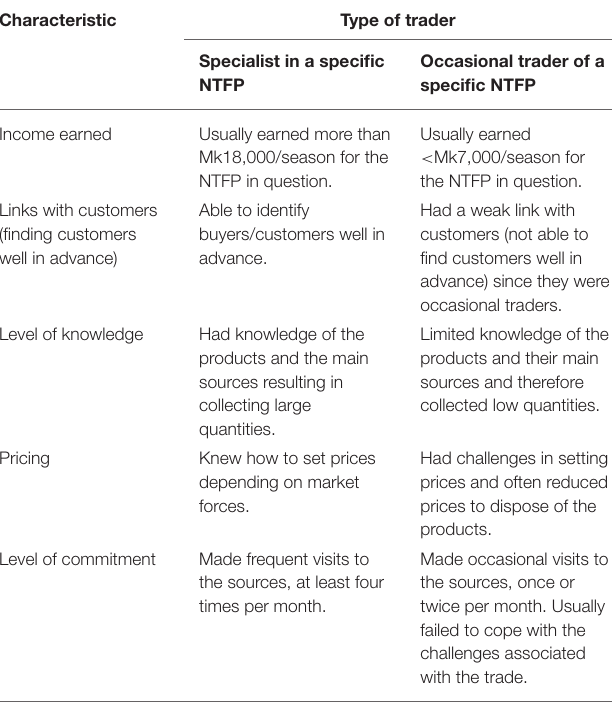
TABLE 7 | Differentiating characteristics of specialist and occasional traders of particular